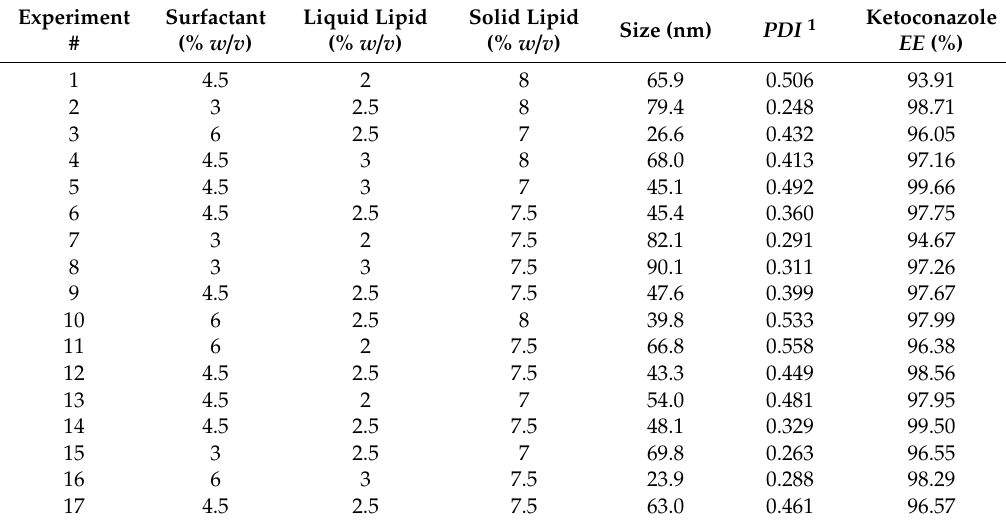
Table 2. Experimental results of the Box-Behnken